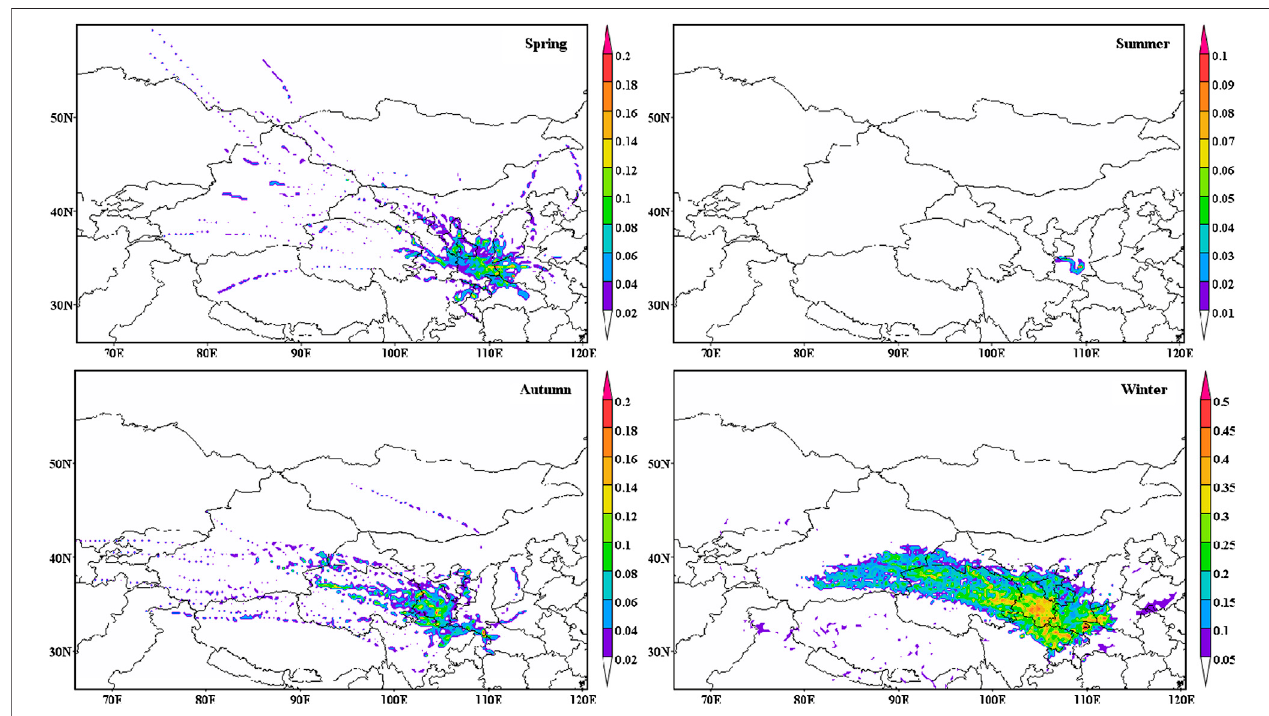
FIGURE 7 | Weighted potential source contribution function distribution of PM 2.5 in different seasons.